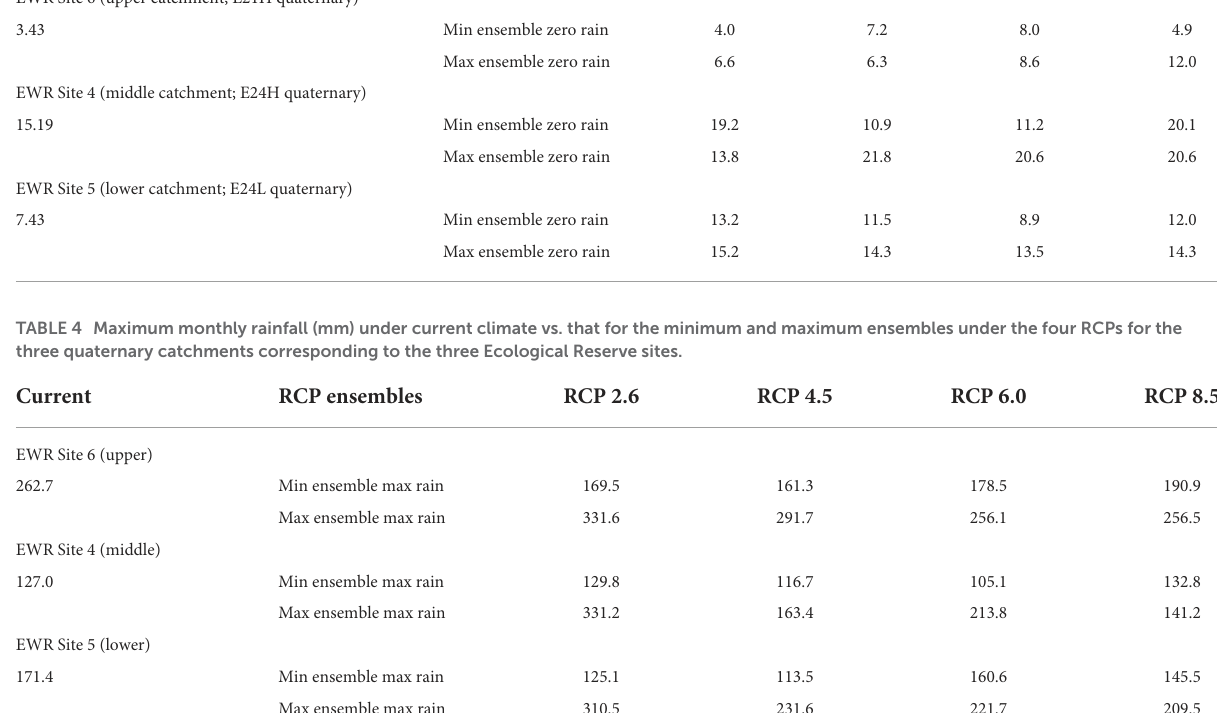
categories A-D relative to the climate change minimum and maximum ensembles for RCP 2.6, respectively. The band of uncertainty under RCP 2.6 approximately corresponds to a B/C Ecological Category during the wet season for site 6, while the range of uncertainty for the dry season is well below the flows RCP 8.5 (figures not shown).